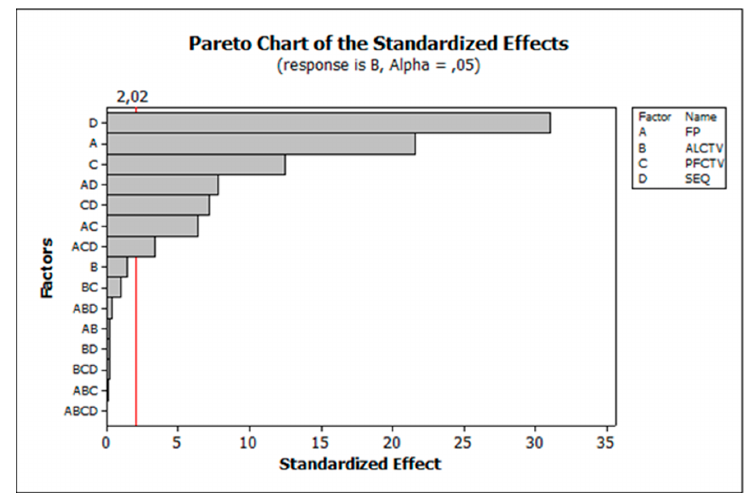
Figure 5. Pareto chart of the standardized effects of the inputs on B.